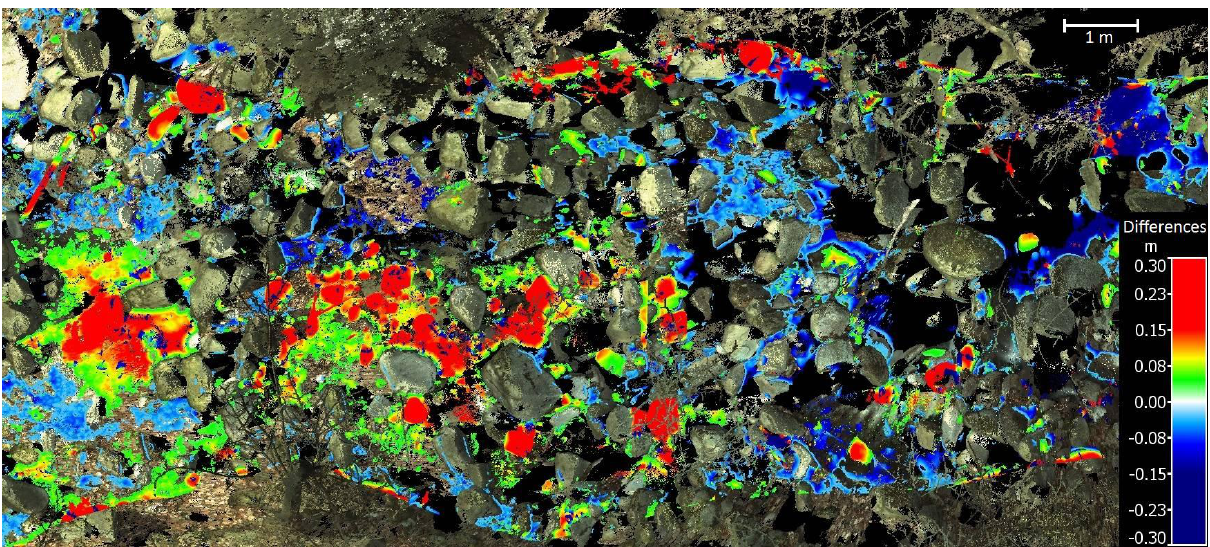
Figure 7. DoD for years 2014-2011 projected over orthoimage; insignificant height differences are